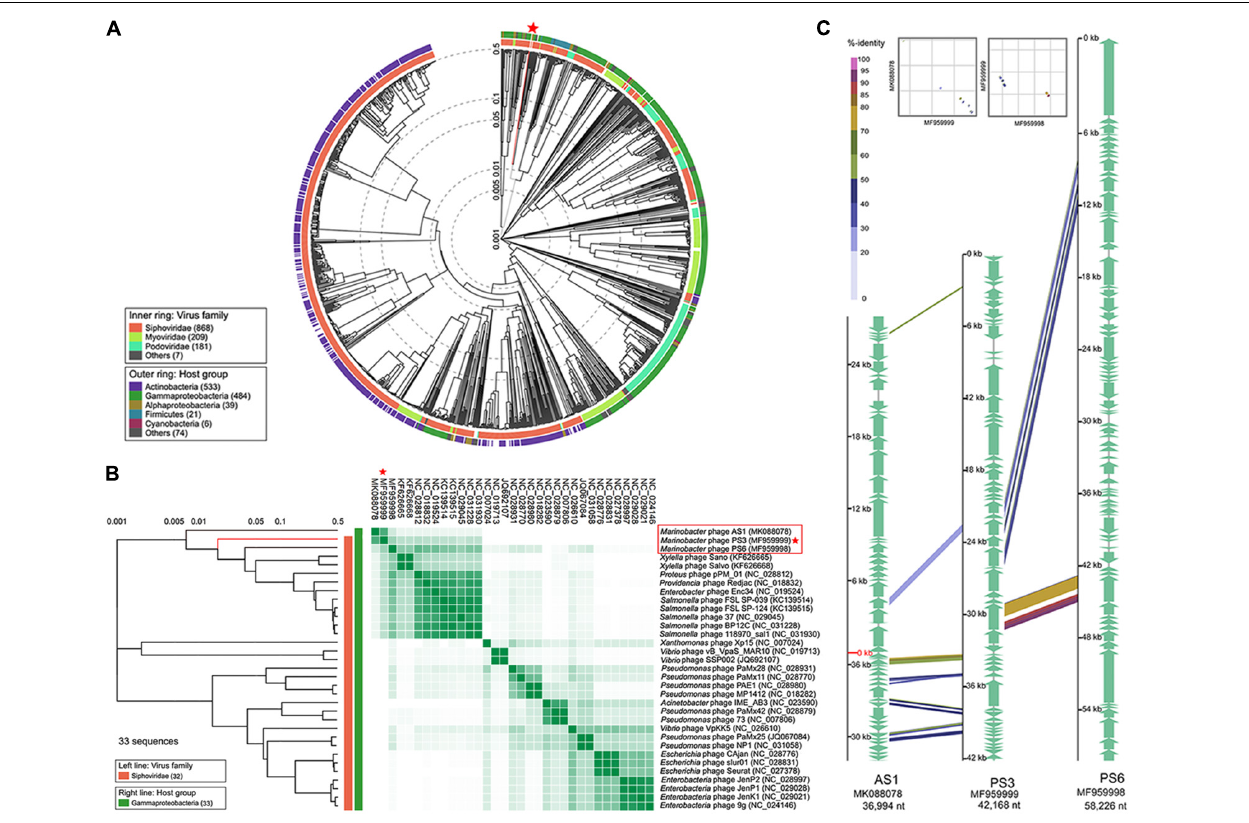
FIGURE 3 | Phylogenetic and comparative genomic analysis of vB_MalS-PS3. (A) Viral phylogenetic tree of whole phage vB_MalS-PS3 genomes represented in the circular view. (B) Viral phylogenetic tree represented in the rectangular view with 32 closely related genome sequences of vB_MalS-PS3, and heatmap showing the percentage of shared genes among 33 genome sequences. The ratio of shared genes was based on all-to-all BLASTP analysis ( E -value < 1E-10). (C) Genomic organization of the Marinobacter bacteriophage vB_MalS-PS3 compared to Marinobacter bacteriophage AS1 and Marinobacter bacteriophage PS6.